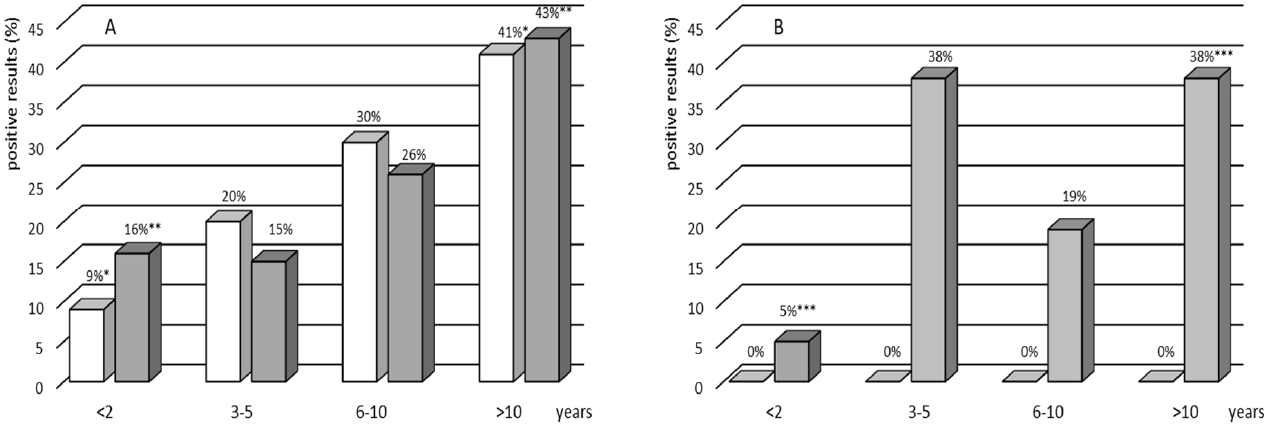
Figure 1. Percentage of the IGRA-positive (white bars) and TST-positive (gray bars) results by age group in the group with ( A ) and without ( B ) TB contact. Asterisks indicate a statistically significant difference at p < 0.05. A nonparametric chi-square test or Fisher’s exact test was used to assess